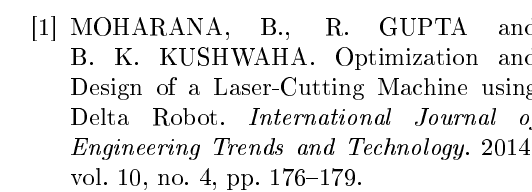
Fig. 18: Position errors of the end-e(cid:27)ector in the case of static pipe.